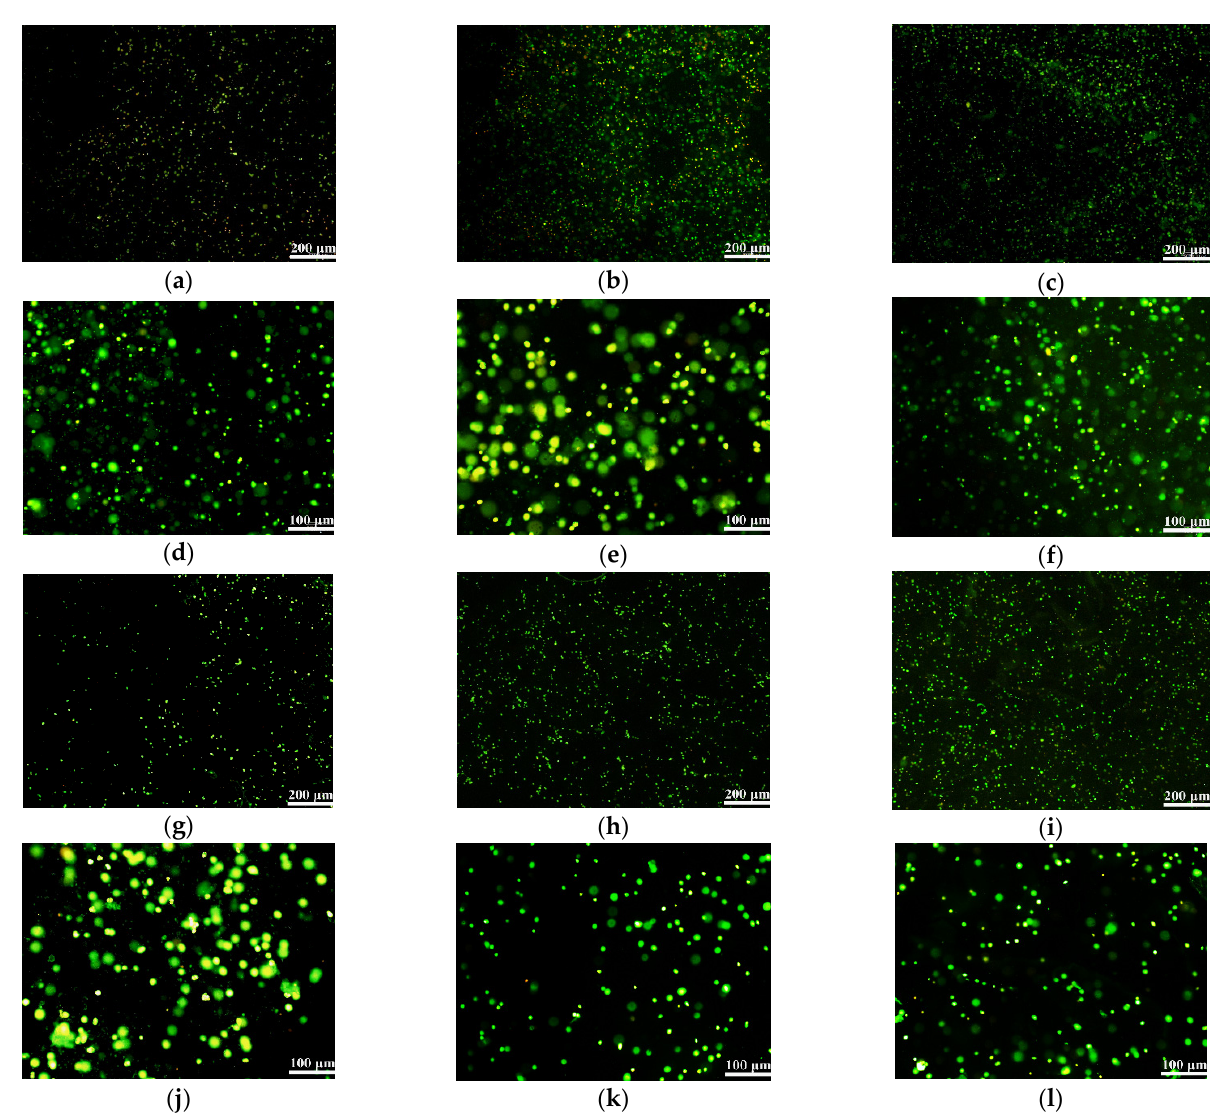
Figure 9. Laser confocal microscoope (LSM) images of AO/PI stained TCA-8113 cells embedded in hydrogels after 1 day: ( a ) G-A hydrogel: the cells are all alive and stained in green; ( b ) G-A-A hydrogel: most cells are green, with some in bright yellow; ( c ) F-A hydrogel: cells are alive and stained in green; ( d ) enlarged image of ( a ); ( e ) enlarged image of ( b ); ( f ) enlarged image of ( c ); ( g ) F-A-A hydrogel: most cells are alive and stained in green; ( h ) A hydrogel: most cells are alive and stained in green; ( i ) A-A hydrogel: cells are alive in green; ( j ) enlarged image of ( g ); ( k ) enlarged image of ( h ); ( l ) enlarged image of ( i ).